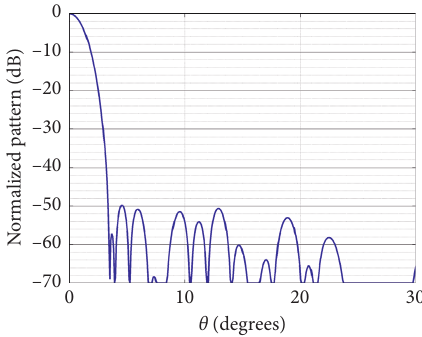
Figure 9: The two-way array pattern for N elements. SLL � − 49.18dB.